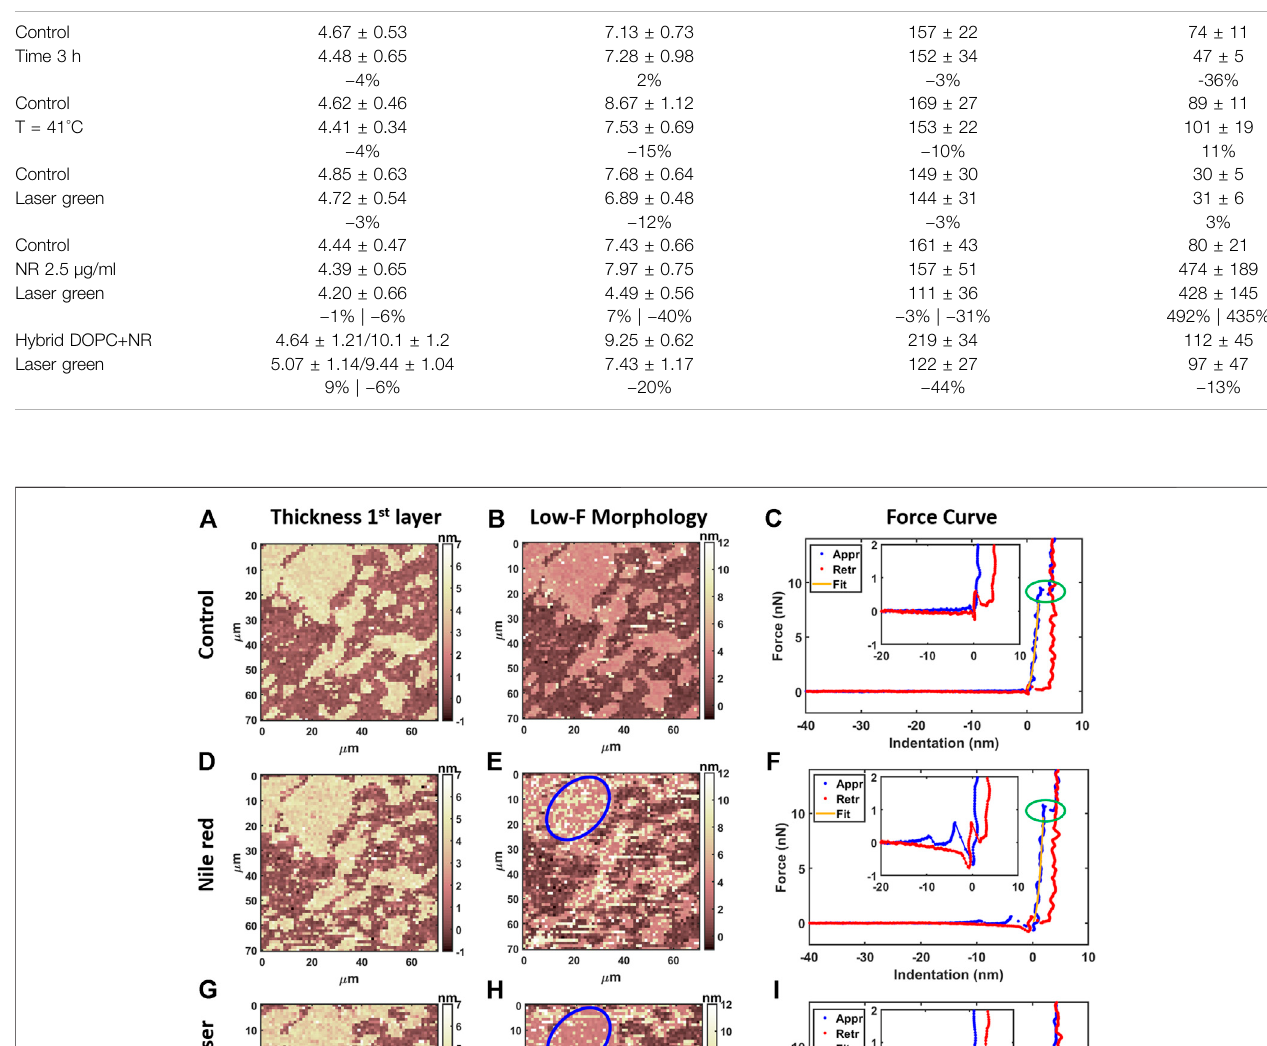
relative to Figure 6 , while data are presented and compared in Table 1 . For instance, after adding Nile red to the solution, the adhesion increases noticeably in agreement with the presence of a weakly bound overlayer that can trap the AFM probe after closing